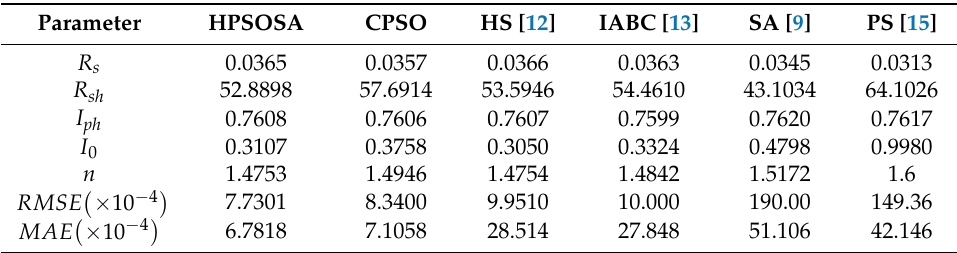
Table 3. Estimated parameters of single diode PV model obtained by HPSOSA and other five algorithms with RMSE and MAE values.